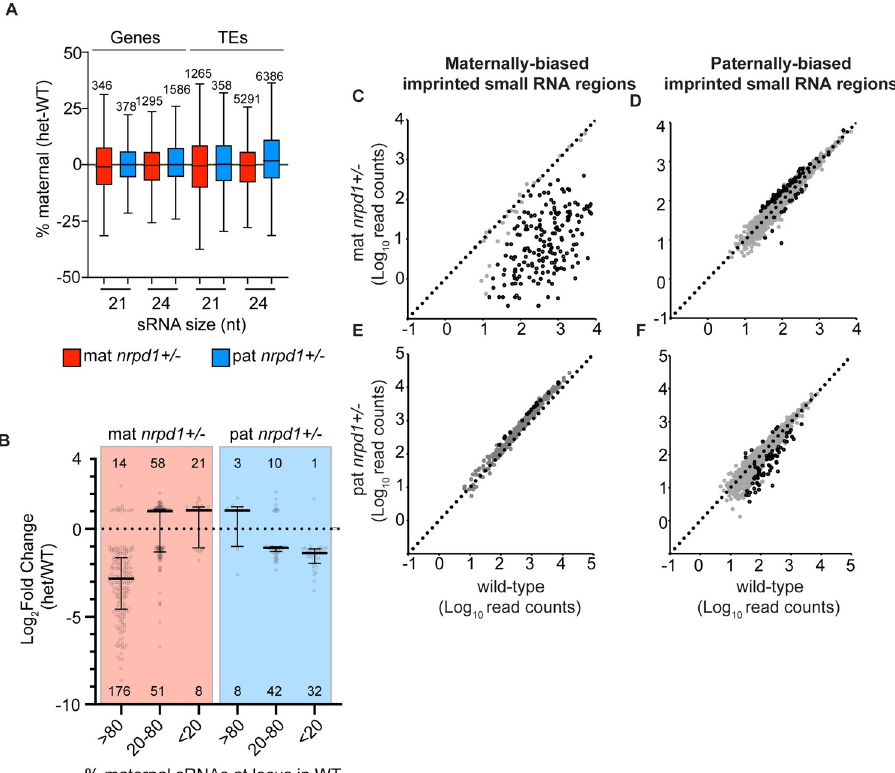
Fig 2. Effects of loss of maternal or paternal Pol IV on the allelic origin of sRNAs. (A) Tukey plot shows no difference in allelic origin of genic and TE sRNAs between nrpd1 heterozygotes and WT. Loci plotted here showed similar sRNA abundances in WT and heterozygotes and have a sum of at least 10 allele-specific reads in 3 WT replicates and in heterozygotes. (B) Loci with reduced sRNAs in mat nrpd1+/− or pat nrpd1+/− exhibit maternally or paternally biased sRNAs in WT. Genes and TEs showing differential abundance of 24-nt sRNAs in nrpd1 heterozygotes were grouped into bins by the % of sRNAs produced from the maternal alleles of that locus in WT. Fold change was calculated by DESeq2. Tukey plot represents fold change in each group; circles show fold change at individual loci. Numbers below and above plot are total number of loci having significantly lower and higher abundance of 24-nt sRNAs in nrpd1+/− relative to the WT. (C–F) Loss of maternal NRPD1 leads to a reduction in the abundance of sRNAs from maternally biased ISRs (C) and gain of sRNAs from a subset of paternally biased ISRs (D). Loss of paternal NRPD1 has a negligible impact on maternally biased ISRs (E) and a relatively minor impact on paternally biased ISRs (F). The Col-L er ISRs used here were defined by Erdmann and colleagues (2017). To identify regions with changes in sRNA abundance, read counts were calculated over sliding windows of 300 bp with 200-bp overlap. Windows with differential abundance were identified using DESeq2. Windows overlapping an ISR were identified using bedtools intersect. Overlapping windows were merged using bedtools merge and the median read count for each set of merged windows was plotted. Windows with and without significant differences in abundance are represented by black and gray circles. Data represented in this figure can be found in S3 Data. ISR, imprinted sRNA region; Pol IV, polymerase IV; sRNA, small RNA; TE, transposable element; WT,